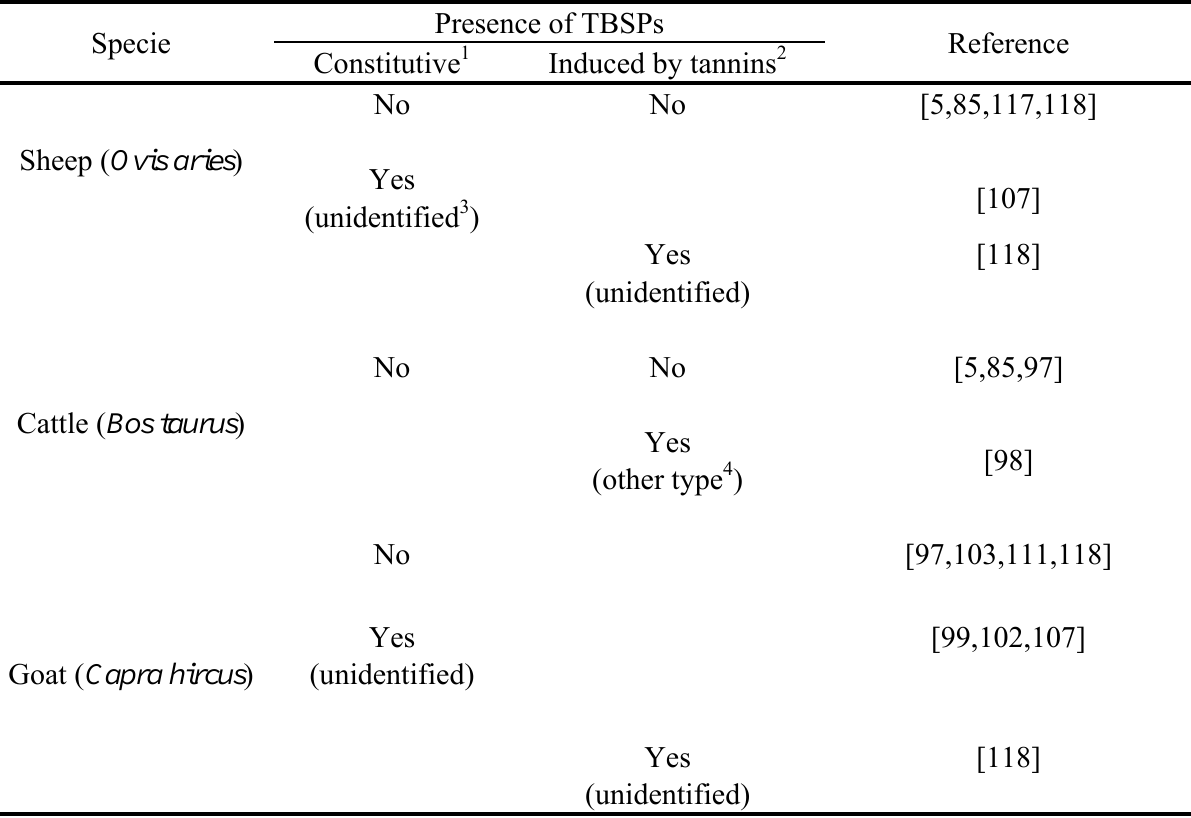
Table 1. List of studies in which the presence of Tannin-binding salivary proteins (TBSPs) was referred for sheep, cattle and